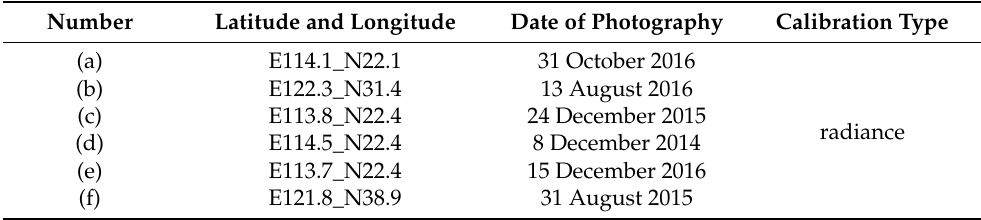
Table 1. The information corresponding to each image in Figure 3. It includes the latitude and longitude information, and imaging date information, of each subfigure in Figure 3. The calibration type of the image is radiance.